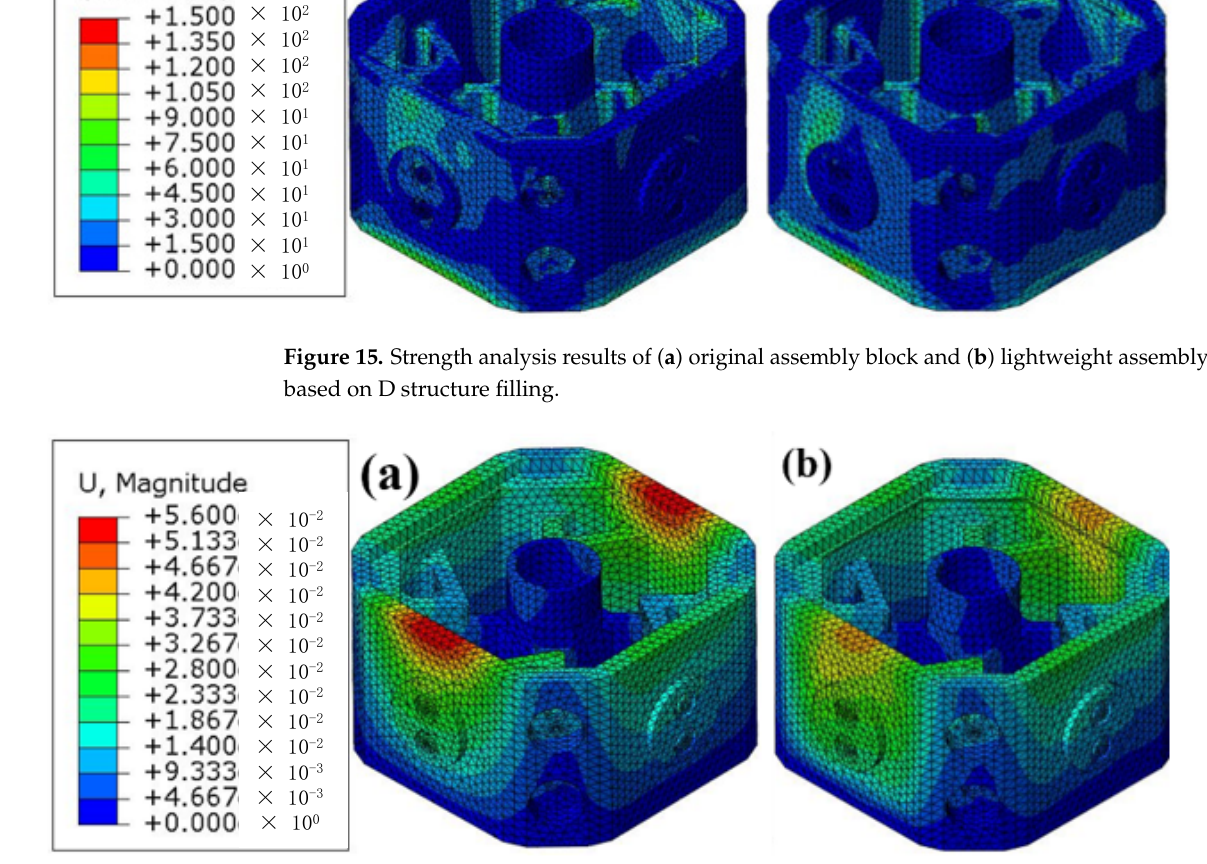
Figure 16. Deformation analysis results of ( a ) original assembly block and ( b ) target lightweight part based on D structure filling.